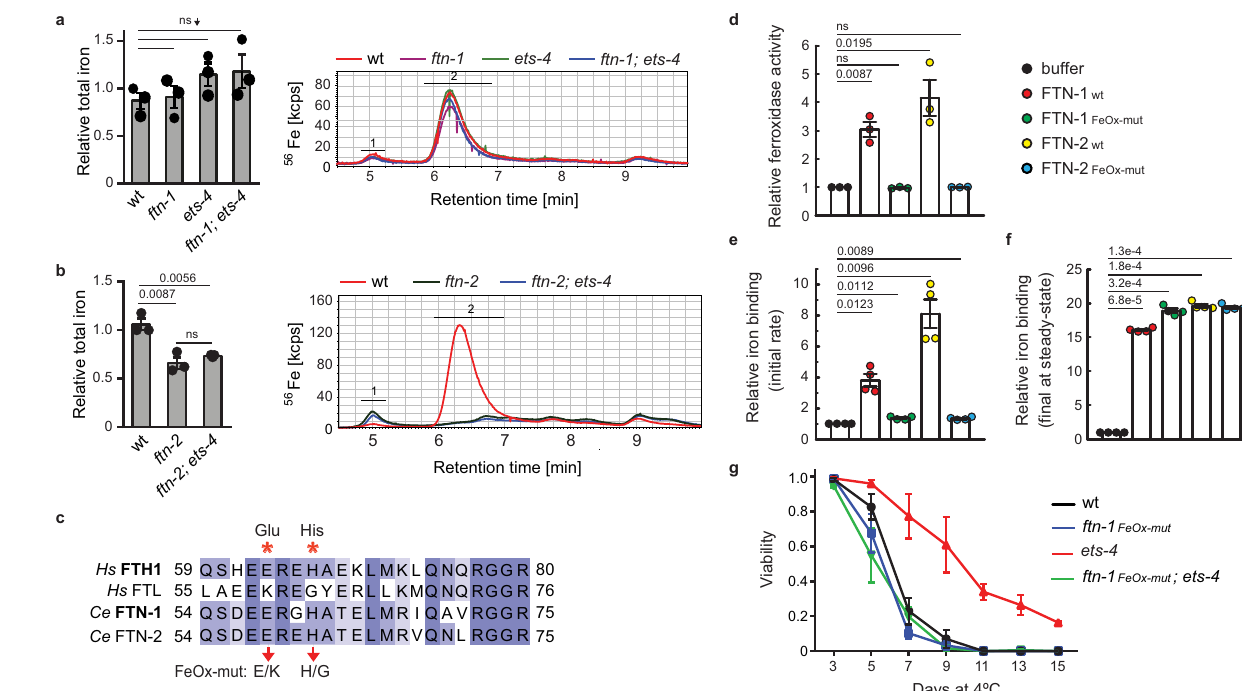
Fig. 6 | FTN-1 promotes cold survival via its ferroxidase activity. a Total body iron isindependent of FTN-1. One-day-old adults: wt, ftn-1(ok3625) , ets-4(rrr16) , and ftn-1(ok3625); ets-4(rrr16) , were cold-exposed (3 days). Total iron in extracts was measured by SEC-ICP-MS and normalized to wt. Right: chromatograms, left: quantitation of area under curves. Peak 1; high molecular weight-associated iron. Peak 2; ferritin-associated iron. n =3 independent experiments. b Total body iron depends on FTN-2. One-day-old adults: wt, ftn-2 ( ok404 ), and ftn-2 ( ok404 ); ets- 4 ( rrr16 ), were cold-exposed (3 days). Total iron in extracts was measured as in a . n =3 independent experiments. c Partial sequence alignment of ferritin homologs. Human (Hs): ferritin heavy (FTH1; NP_002023.2) and light (FTL; NP_000137.2) chains. C.elegans (Ce):FTN-1(NP_504944.2)andFTN-2(NP_491198.1).Redasterisks indicate amino acids mutated (E58K/H61G) in ferroxidase-de fi cient FTNs (FeOx- mut). d The FeOX-mut mutations abrogate the ferroxidase activity of FTNs. Fer- roxidase activity ofrecombinant FTN-1 or − 2, either wt orFeOx-mut,wastested on